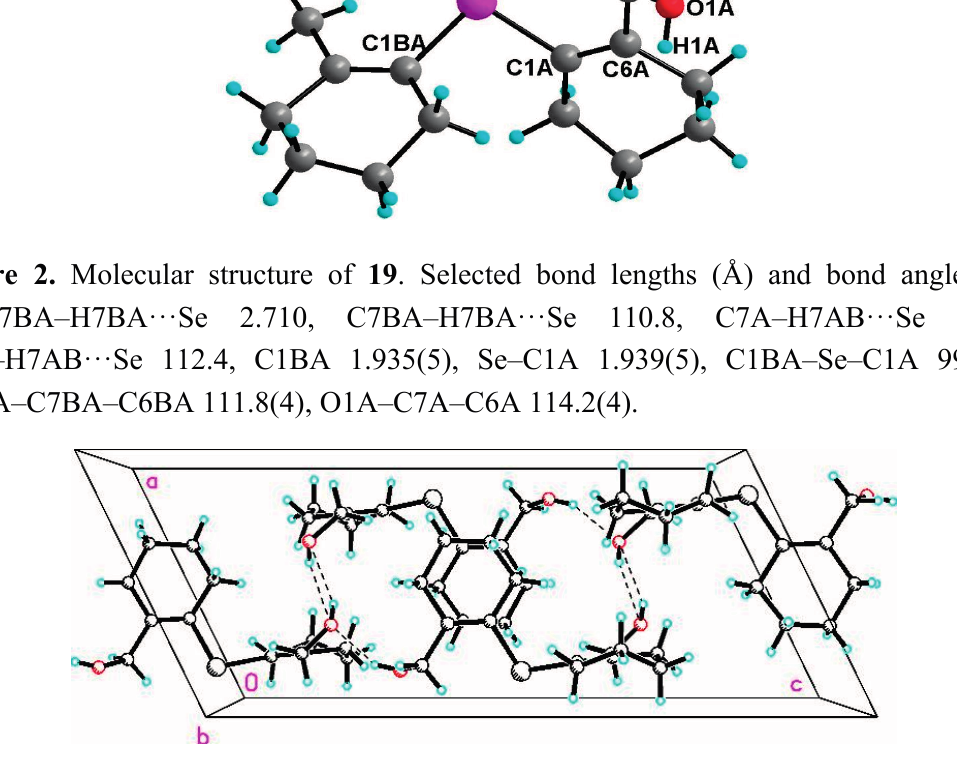
Figure 3. The short OH···O intermolecular interactions (OH···O, 2.163